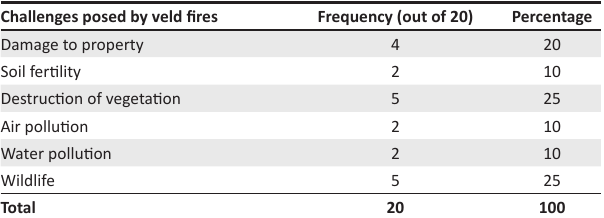
TABLE 1: Challenges to sustainability caused by veld